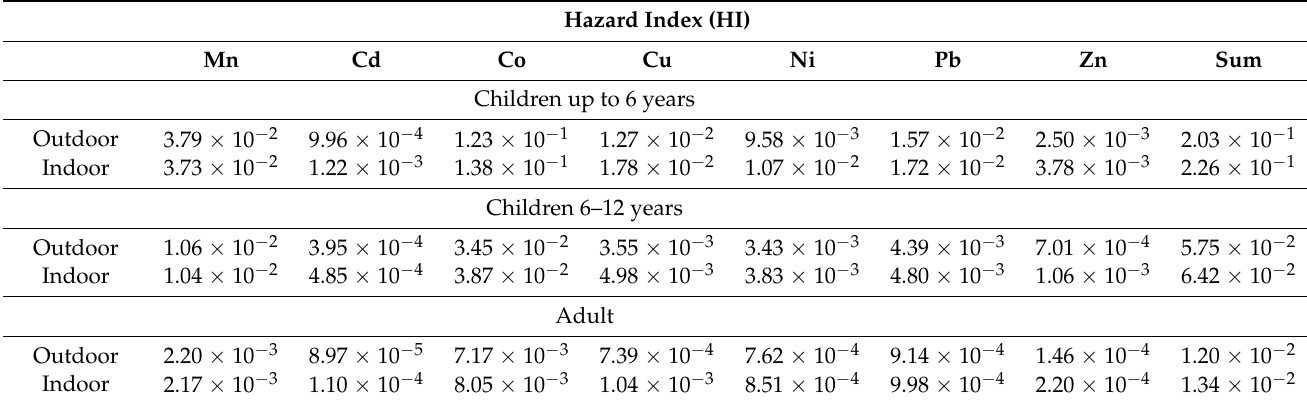
Table 4. Average hazard index (HI) of dust in outdoor and indoor